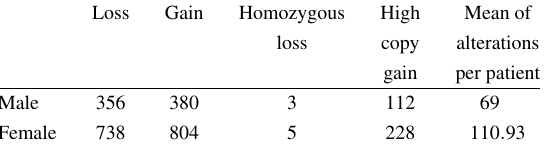
Different number of alterations in male and female